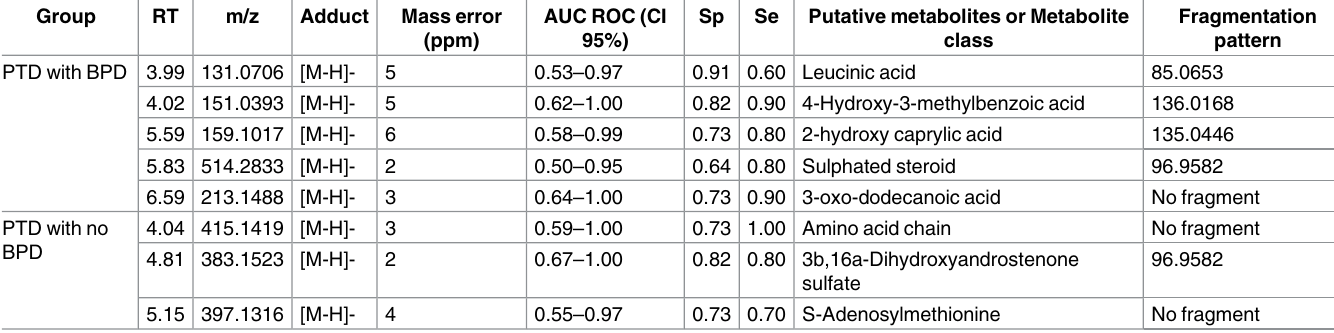
RT = Retention Time; m/z = mass-to-charge ratio; ppm = part per million; AUC = Area under the Curve; ROC = receiver operating characteristics; Sp = specificity; Se = sensitivity; the optimal threshold used for specificity and sensitivity is the point closest to the top-left part of the plot with perfect sensitivity or